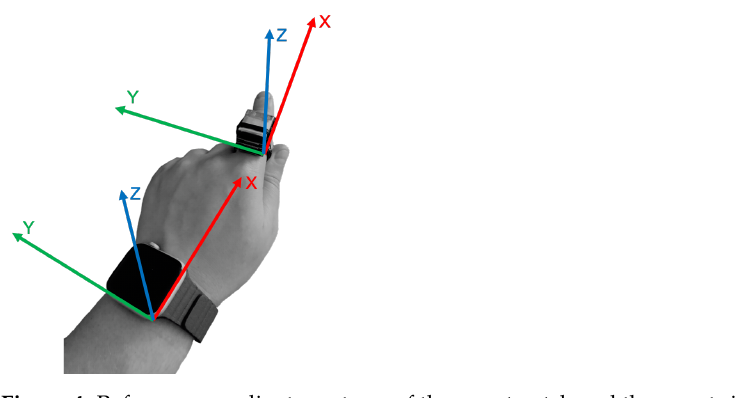
Figure 4. Reference coordinate systems of the smartwatch and the smart ring.